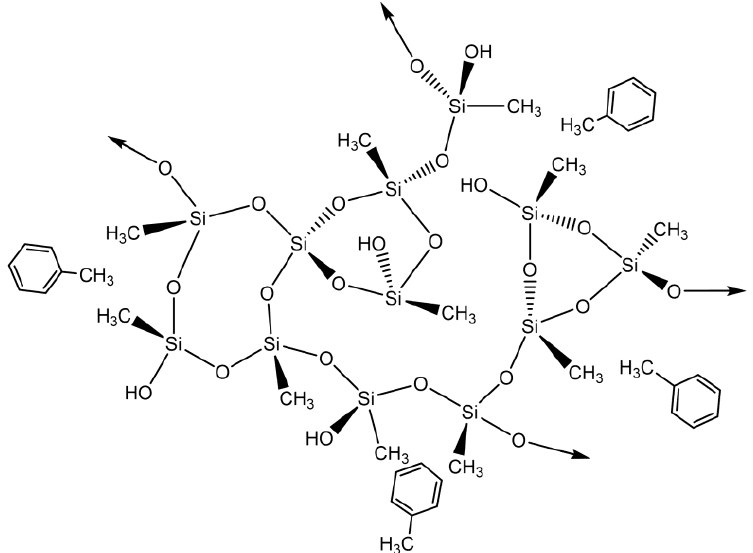
12 of 30 Figure 3. ( a ) — Experimental equilibrium data and the best fitted isotherm model for adsorption of toluene into the studied aerogels (dotted line — Langmuir; solid line — Freundlich; dashed line — BET). ( b ) — Representative plots of the fit of non-linearized form of pseudo-second order equation (solid line) to the data of experimental adsorption capacity as function of time, for the studied ad- sorbents towards toluene ( C 0 = 100 ppm, 15 rpm, 20 °C). Regarding the adsorption of toluene, each material has a different isotherm model that provides a better fit; for the 100M, the model was Langmuir, suggesting that the ad- sorption occurs on a homogeneous surface and a monolayer of the sorbate is formed [56]. The model for the 100M_CNT-HNO 3 _10 was BET, indicating that a multilayer